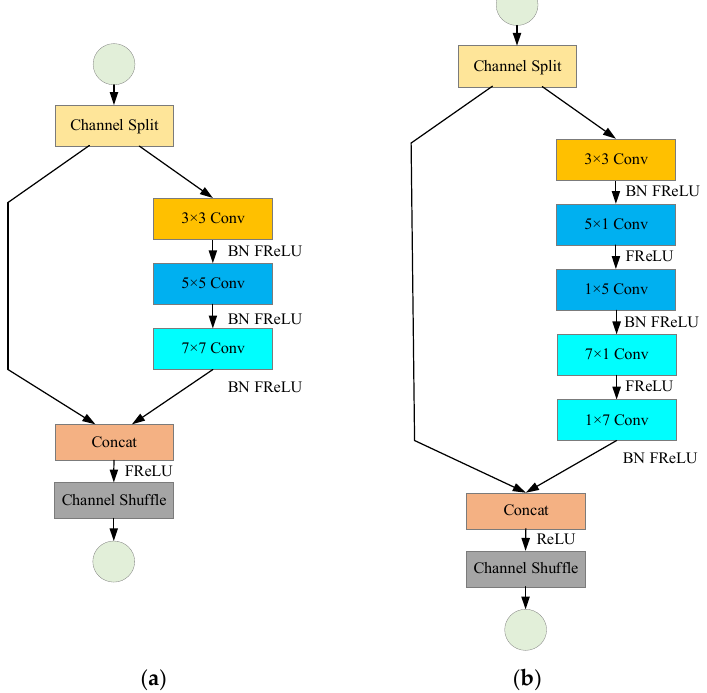
Figure 2. Multi-scale shuffled convolution module and multi-scale asymmetric shuffled convolution module. ( a ) Multi-scale shuffled convolution module. ( b ) Multi-scale asymmetric shuffled convolu- tion